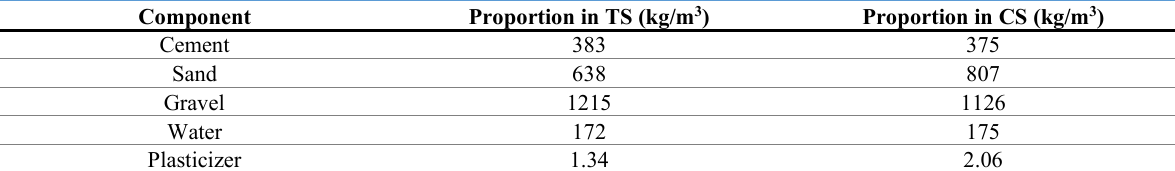
Table 1. TS’ and CS’ concrete